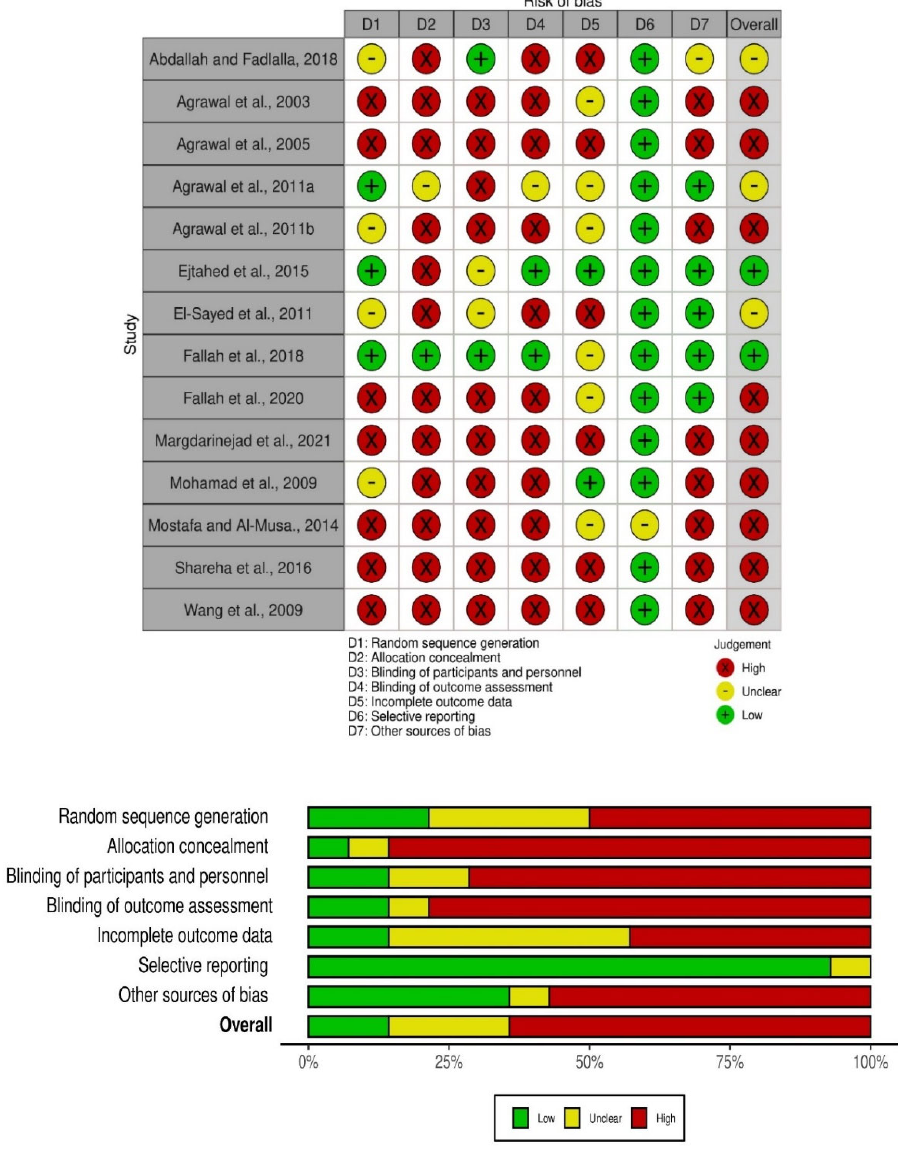
Figure 16. Risk of bias ( a ) Risk of bias summary: each risk of bias item for each included study; ( b ) risk of bias graph: each risk of bias item presented as percentages across all included studies. Green: Low risk of bias; Yellow Unclear risk of bias; Red High risk of bias ( n = 14).